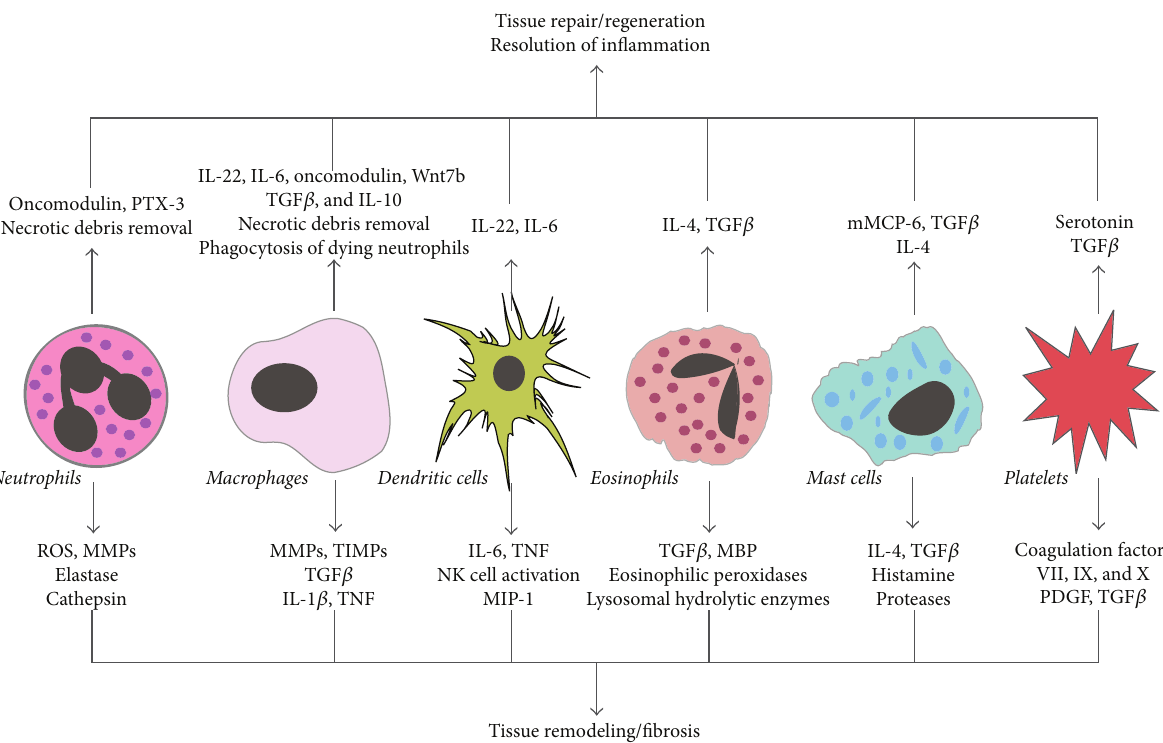
Figure 2: Mediators of innate immune system in regaining tissue homeostasis. Innate immune cells secrete several cytokines, growth factors, andenzymes,whichpromoteseitherresolutionofinflammationandtissuerepair/regenerationortissueremodeling/fibrosis.PTX3:pentraxin 3, ROS: reactive oxygen species, IL: interleukin, TGF: transforming growth factor, MMP: matrix metalloproteinase, TIMP: tissue inhibitor of matrix metalloproteinase, TNF: tumor necrosis factor, MIP: macrophage inhibitory protein, MBP: major basic protein, mMCP: mouse mast cell protease, and PDGF: platelet-derived growth